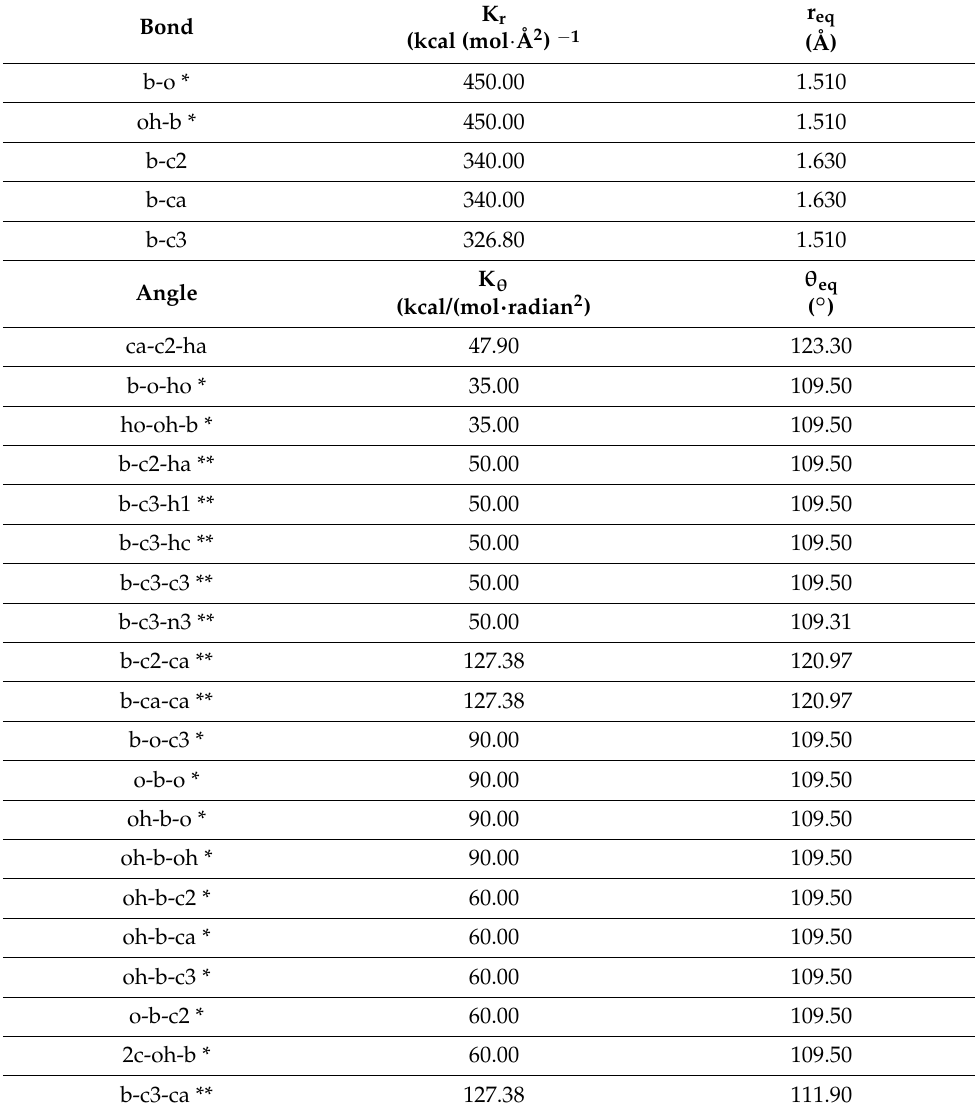
Table 2. Bond and angle Amber force-field parameters taken from literature data for compounds 1 – 4